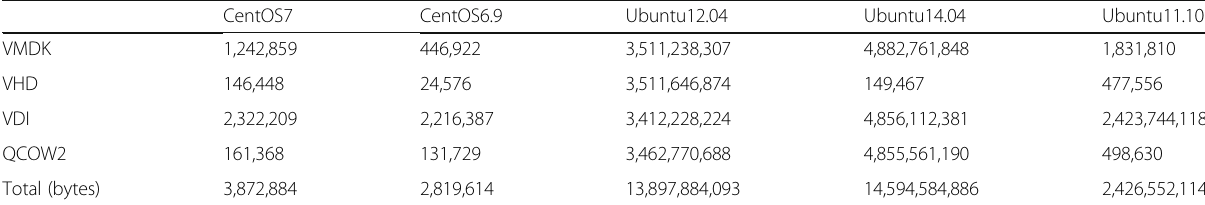
Table 1 Virtual Machine disk images in the data set